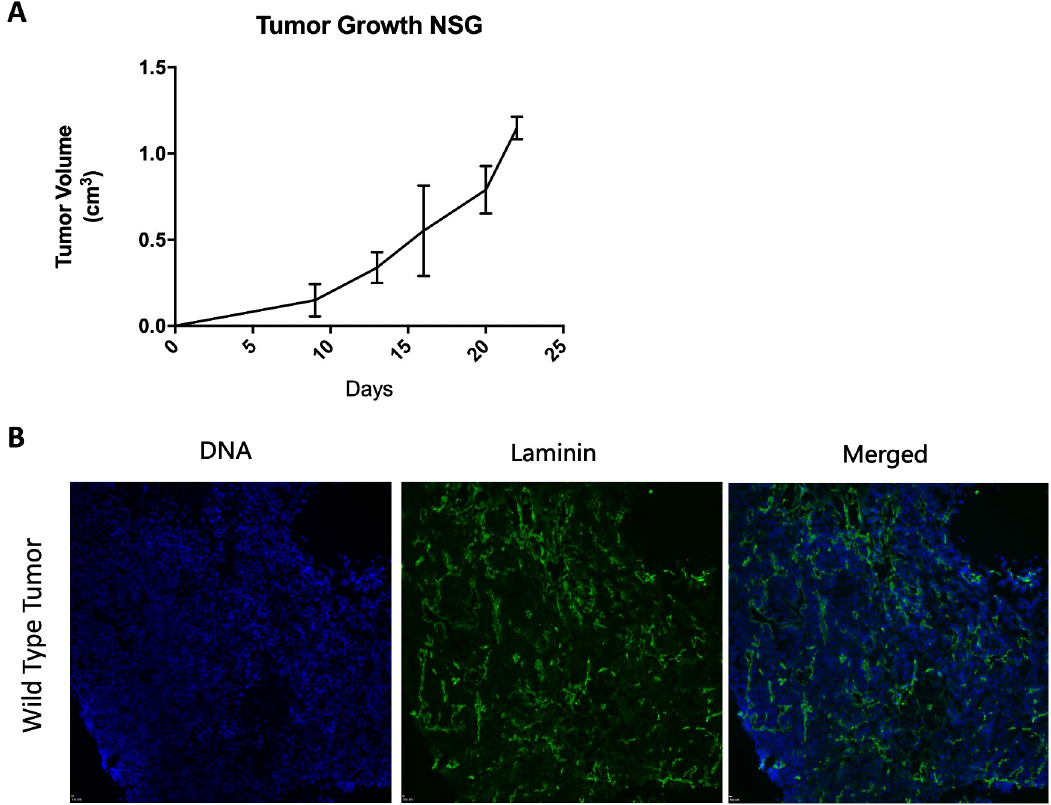
Fig 1. Characterization of the HC-04 cell line. (A) Ectopic huLiver (n = 5) growth curve. Ectopic huLiver growth was followed for up to 22 days after s.c flank injection of 5.0 X10 6 HC-04 cells in NSG mice. (B) Vascularization of the ectopic huLiver by immunofluorescence labeling. DNA was visualized using DAPI (blue), and polyclonal rabbit anti-laminin Dylight 488 antibody (PA5-22901 Invitrogen) was used to show vascularization of the ectopic huLivers (green).